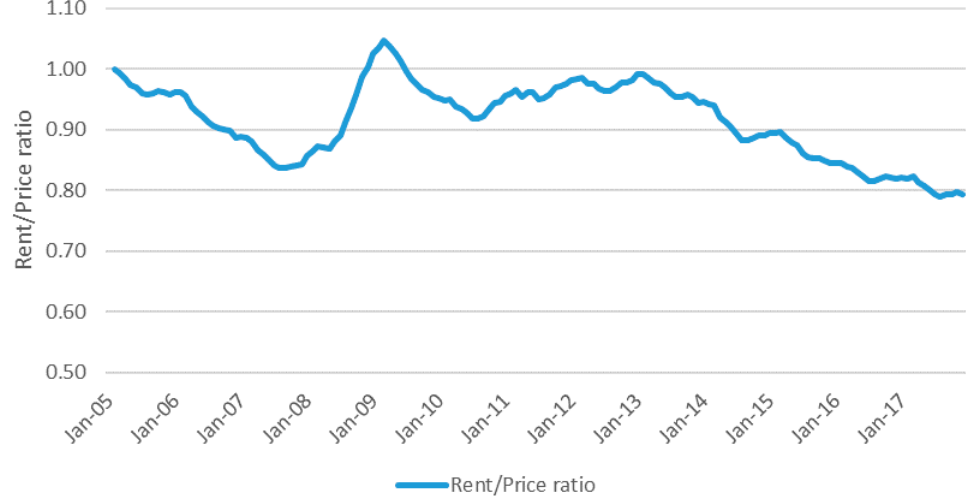
Figure 1. Monthly rent to price ratio, 2005–2017, U.K. Office for National Statistics (ONS), United Kingdom.